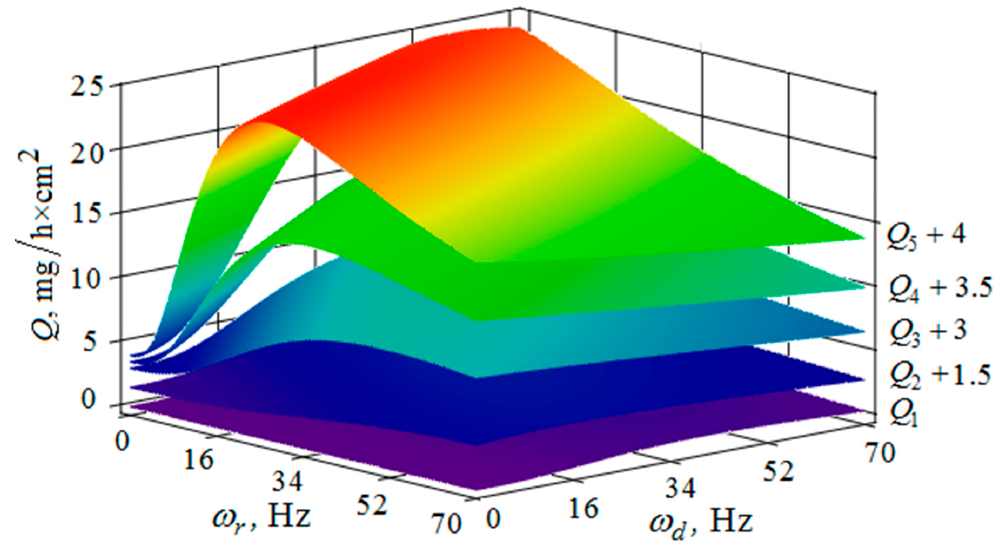
Figure 15. Dependence of the metal removal Q , mg / h · cm 2 on frequencies oscillations ω r , Hz and ω d , Hz of the reservoir working surface and the processed part for different values of the amplitude of the oscillations of the reservoir working surface: ( Q 1 , Q 2 , Q 3 , Q 4 , Q 5 —metal removal at A d = 1; 2; 3; 4; 5 mm); the amplitude A d of oscillations of the part surface 1 mm.